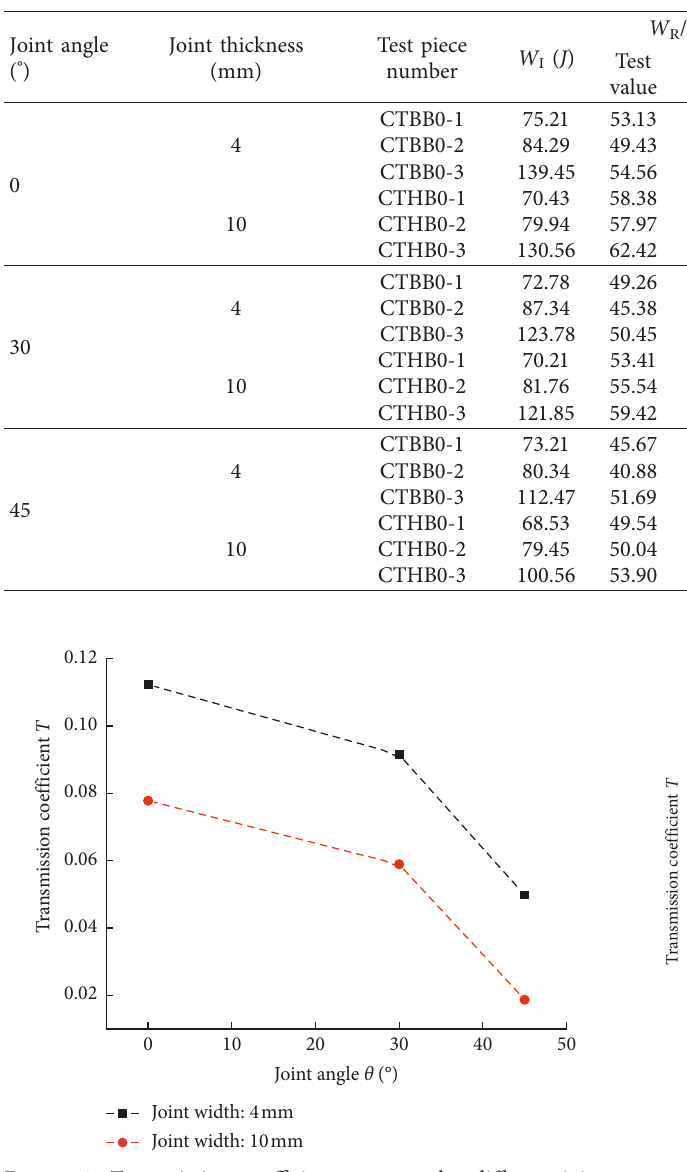
Figure 8: Transmission coefficient curve under different joint angles.